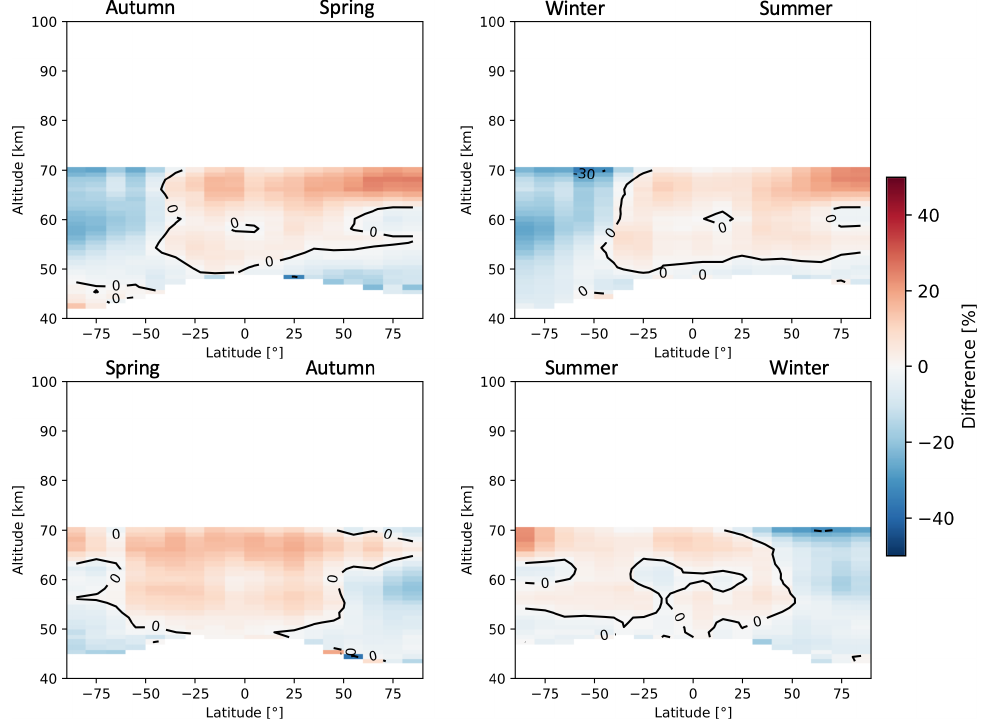
Table 2. The seasons are intended as astronomical seasons, i.e. each starting at the respective solstice or equinox.